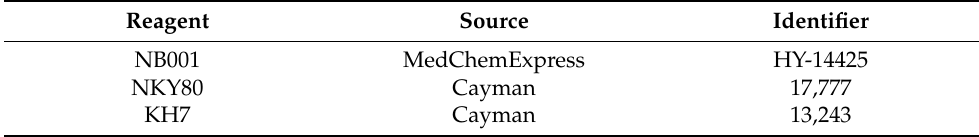
Table 2. The information of adenylyl cyclase (AC) subtype